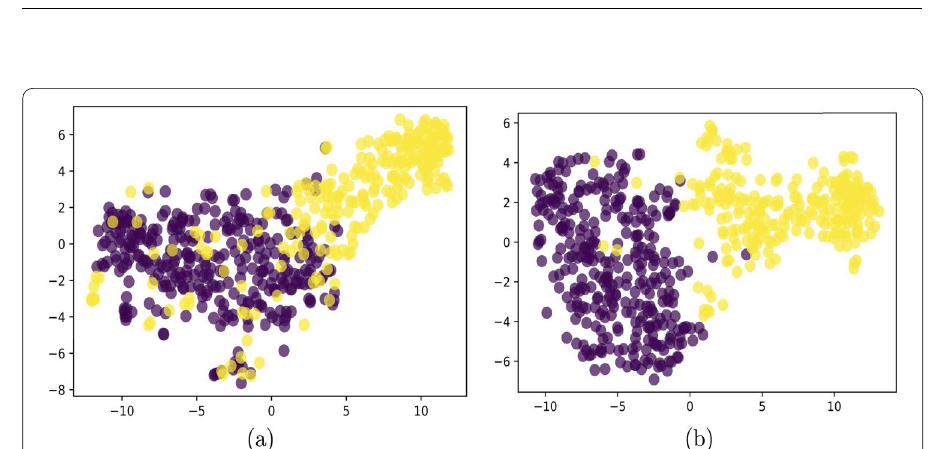
Fig. 3 t -SNE 2D visualization of the entity embeddings learned from ML-GAT over Koumbia -2: a after one epoch, b after 1000 epochs